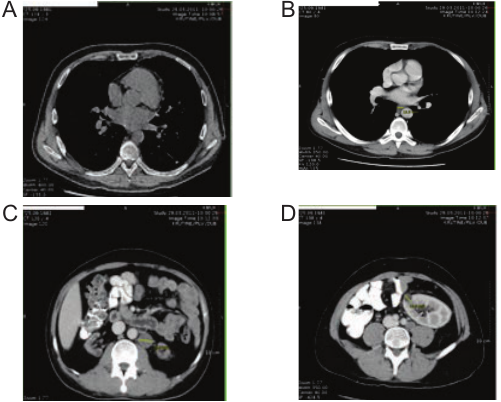
Figure 5. Thoracic, abdominal and pelvic CT scans. (A and B) Multiply small 0.2 – 0.9cm in diameter metastases in both lungs. (C) Pathological 3.7x 2.7cm lymph nodes in posterior mediastinum. (D) Conglomerates of multiply pathological paraaortic lymph nodes. (E) Metastasis in transplanted kidney.